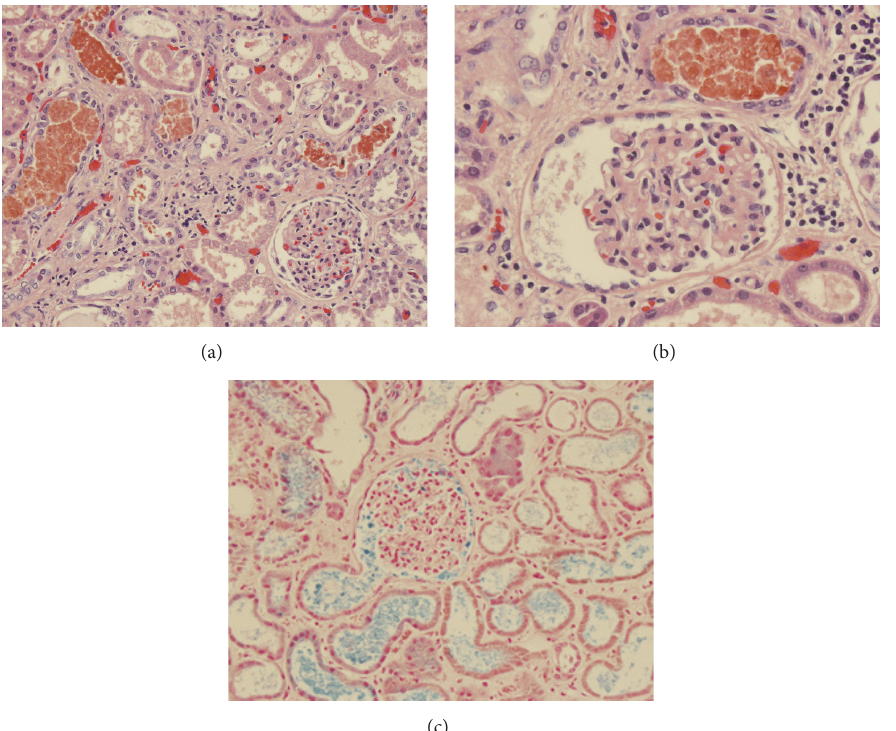
Figure 1: ((a), (b)) Unremarkable glomeruli with acute tubular injury with scattered inflammatory cells and intratubular granular-pigmented cast and (c) Prussian blue stain highlighting the intratubular and intraglomerular pigmented